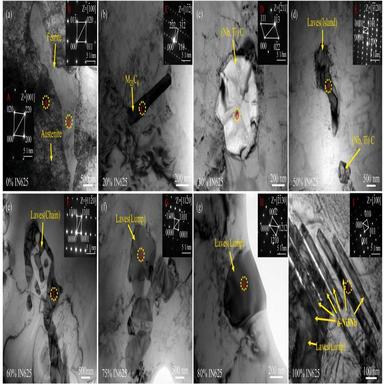
The bright-field TEM images of the secondary phases. (a) Austenite and ferrite, (b) acicular M23C6, (c) granular MC, (d) island Laves, (e) chain Laves, (f-g) lump Laves (h) δ-Ni3Nb.